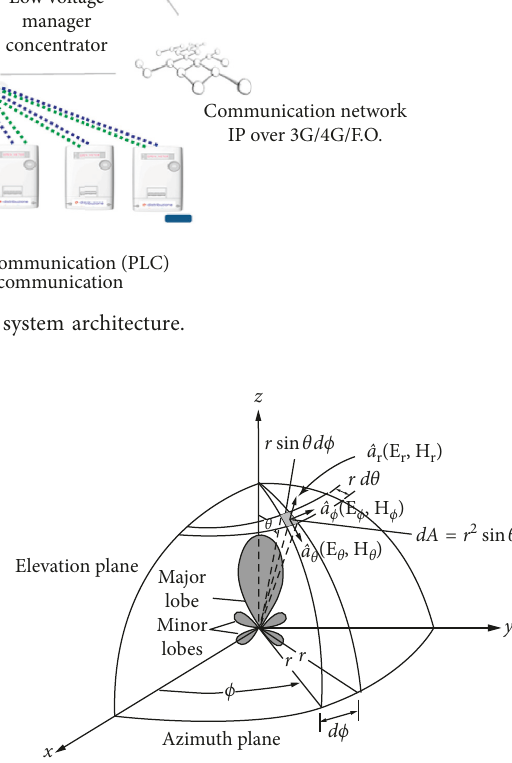
Figure 4: Spherical coordinate system for antenna analysis.